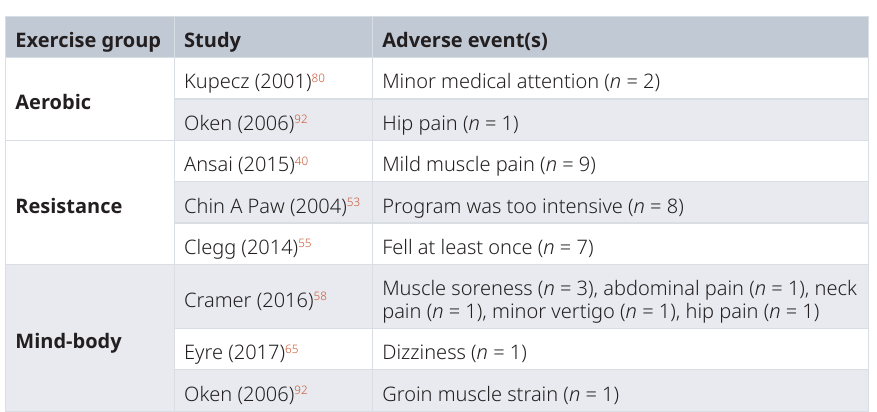
Table 2. Adverse events from included studies.